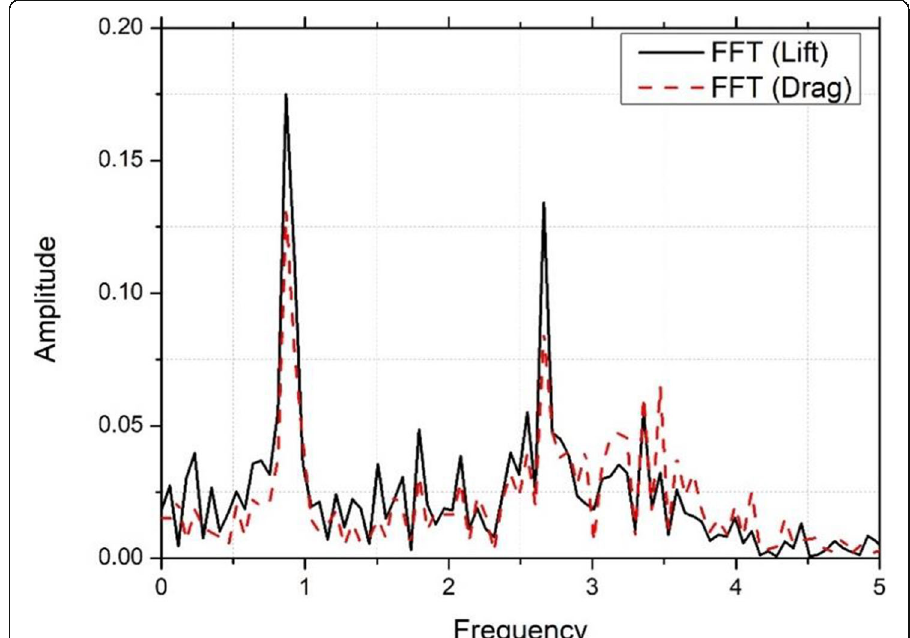
Fig. 4 Spectral analysis of the local force coefficients for rotating Magnus rotor with AR =